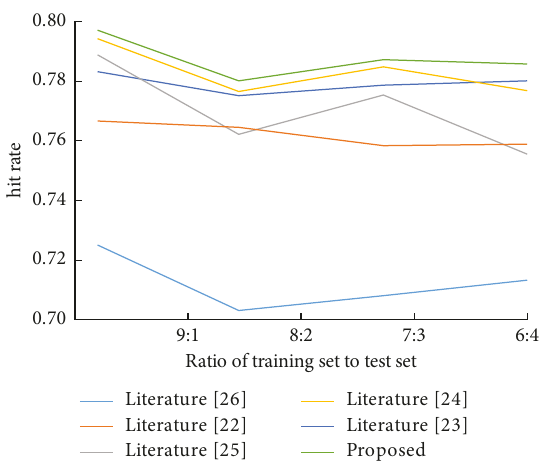
Figure 6: Prediction performance comparison (social sciences).